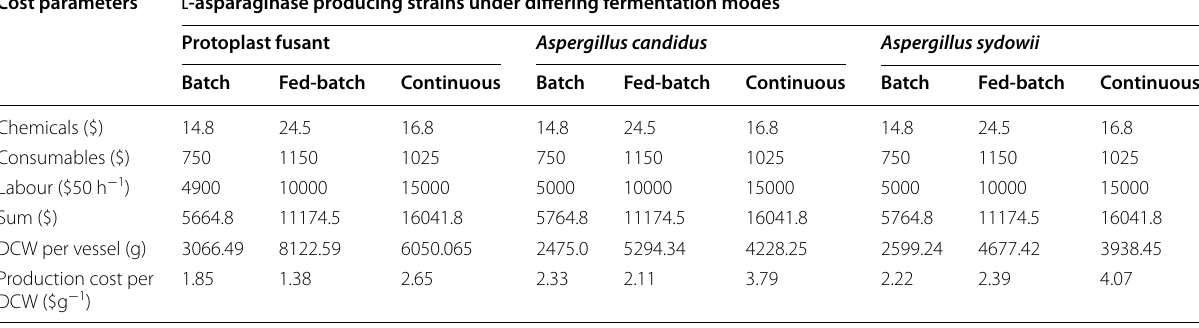
Table 2 Cost analysis of fermentation modes towards l -ASNase production by Aspergillus protoplast Fusant-06 and wild strains in